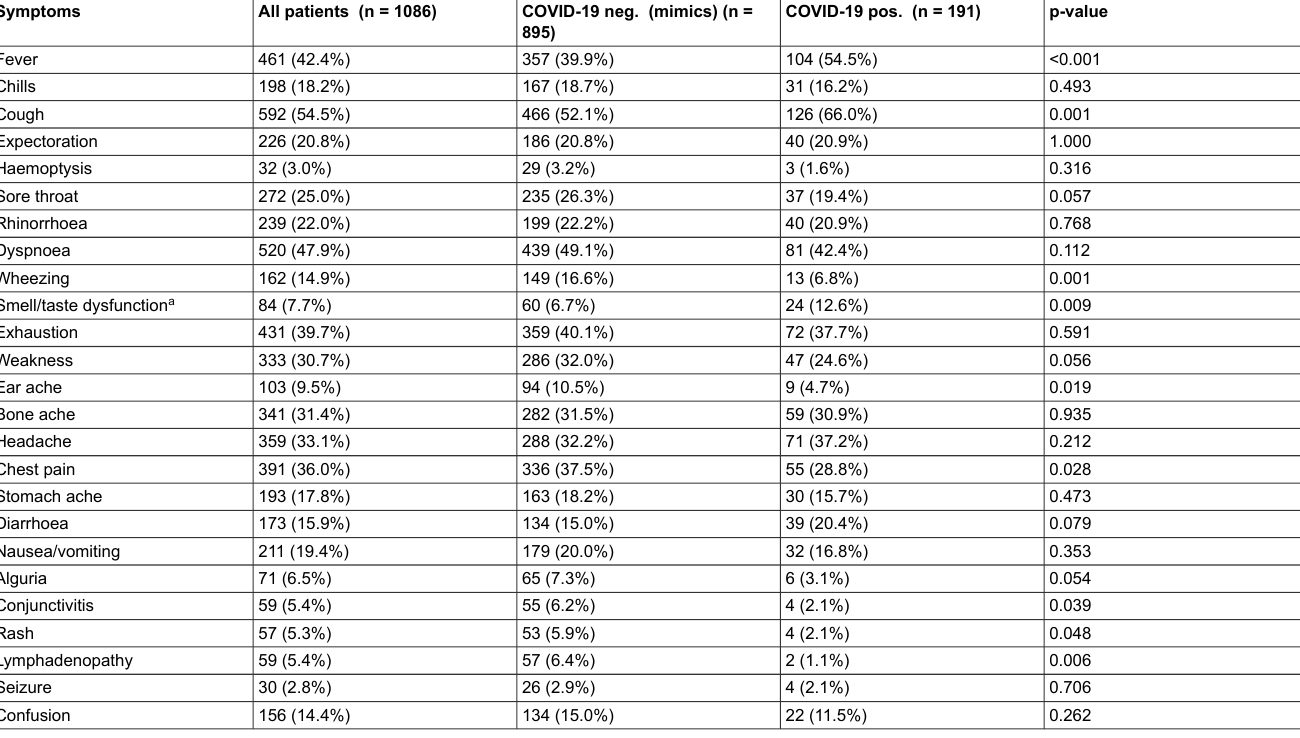
Table 3: Symptoms in all patients clinically suspected of COVID-19.